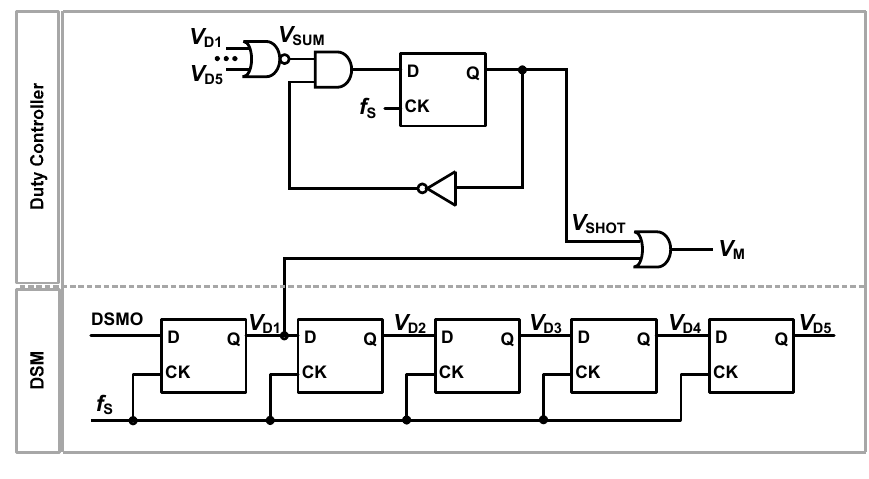
Figure 3. Proposed duty cycle limiter.